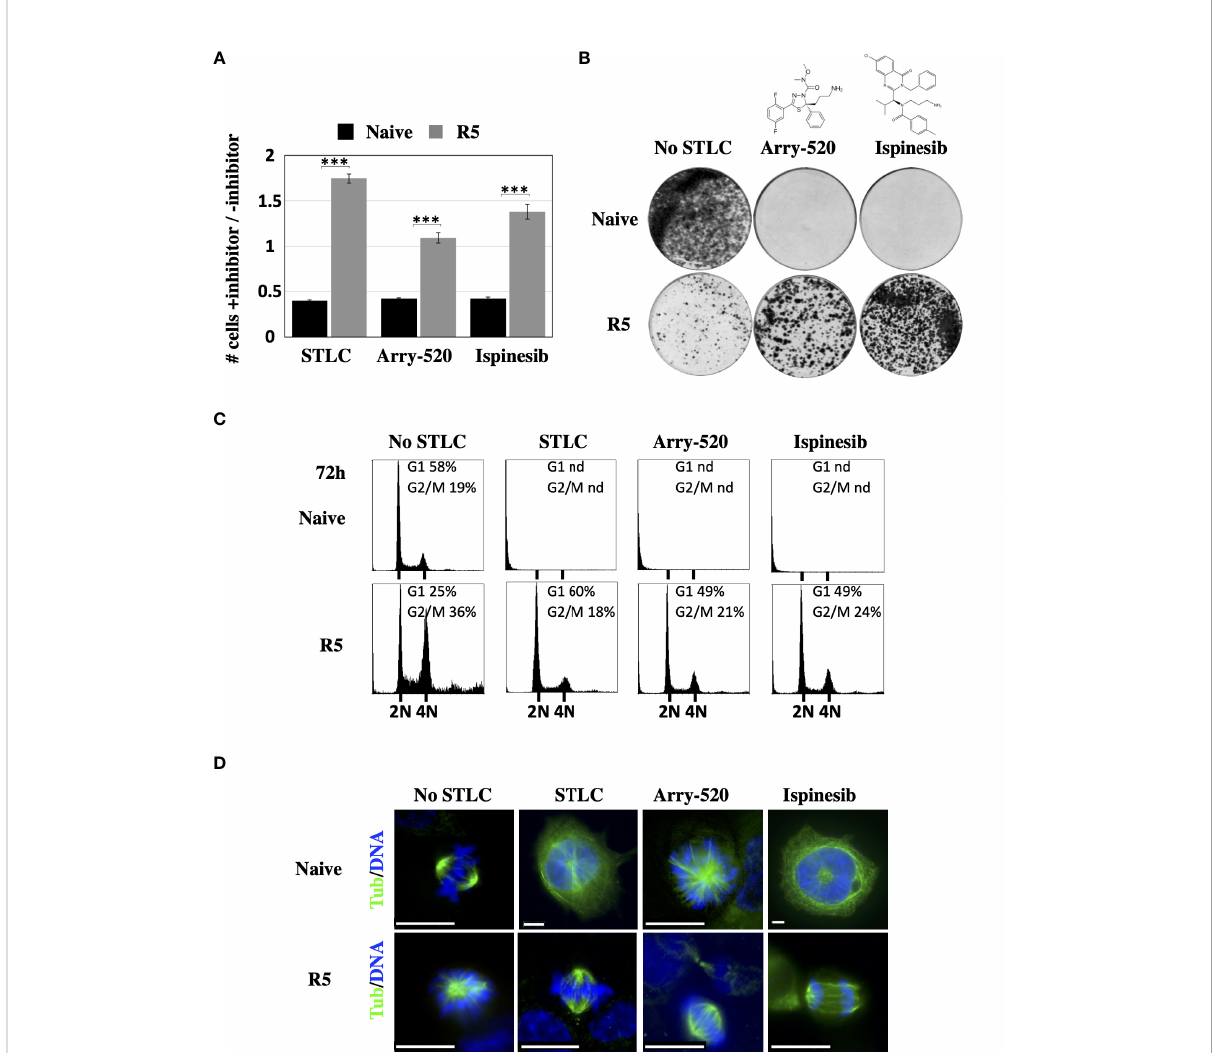
FIGURE 5 Response of the Eg5(T107) expressing cells to Arry-520 and ispinesib (A) Proliferation of STLC resistant and dependent cells in the presence and in the absence of STLC (10 m M) or Arry-520 (10nM) or ispinesib (10nM). Ratio of the number of cells in the presence of STLC (10 m M) or Arry-520 (10nM) or ispinesib (10nM) divided by the number of cells in the absence of the inhibitor for unselected HCT116 cells and cells from the STLC resistant clone R5, after 72h. Asterisks indicate signi fi cance values *** p < 0,0001; (B) Crystal violet-stained colonies of parental HCT116 cells and STLC-resistant and resistant clone R5 cells after 14 days exposed to either media or Eg5 inhibitors, Arry-520 (10nM) and ispinesib (10nM). (C) Cell-cycle progression of STLC-resistant and -dependent clone R5 exposed to STLC, Arry-520 and ispinesib for 72h. (D) Immuno fl uorescence microscopy images of mitotic cells from naive wild type (WT) and STLC -resistant and -dependent cell line clone R5, in the absence and in the presence of STLC, Arry-520 and ispinesib. Microtubules were detected with an anti-tubulin antibody (green) and chromatin with DAPI (blue). Scale bar in the images corresponds to 10 m